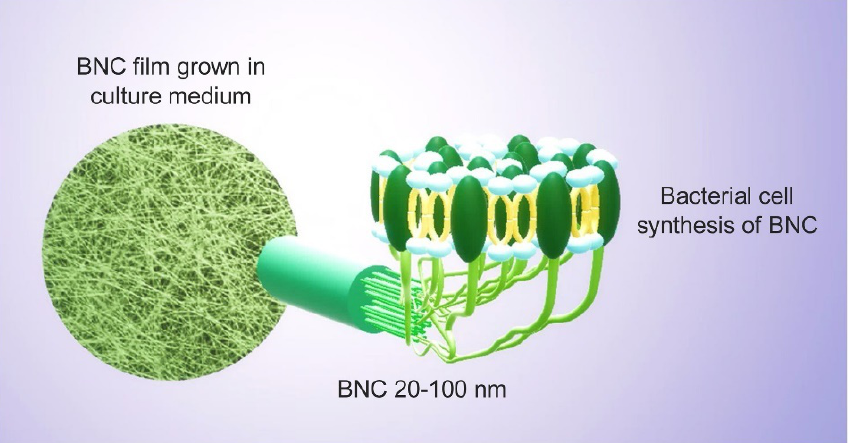
Figure 14. Representation of BNC synthesis. Reprinted/adapted with permission from [40]. Figure 9. Representation of BNC synthesis. Reprinted with permission from Ref. [40]. Copyright 2020 Elsevier Ltd. All rights reserved.